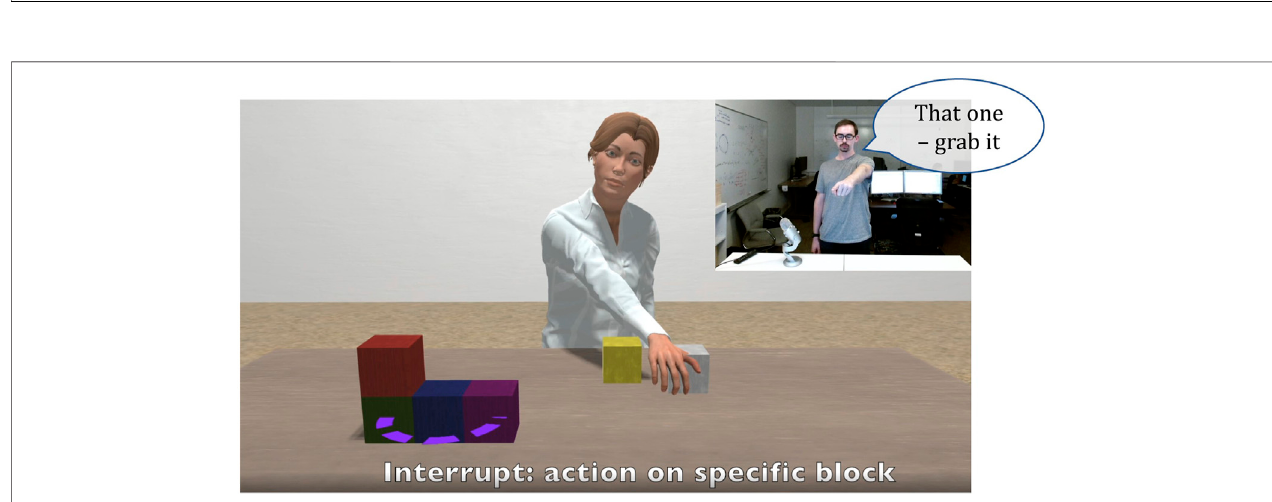
FIGURE 3 | Awareness of the evolving situation: DAVID is an agent that works with a human user partner to manipulate blocks and answer spatial and temporal questionsabouttheevolvingblocksworldscene.Herethesystemdemonstrates Context-awareness HallmarkCA-14: Themachinerespondsappropriatelytohuman referencesandactionsinthecontextoftheevolvingsituation ( includesanythingbuiltandpiecesavailable )bycorrectlyansweringquestionsaboutthelocationsofblocks both before and after the block moves shown. This dialogue takes place at the time of the third photo. The human partner ’ s utterances are spoken, and the log excerpt here shows the computer ’ s interpretation of the speech. The images and associated log text were provided by the DAVID system (Georgiy Platonov, unpublished data, 2020).